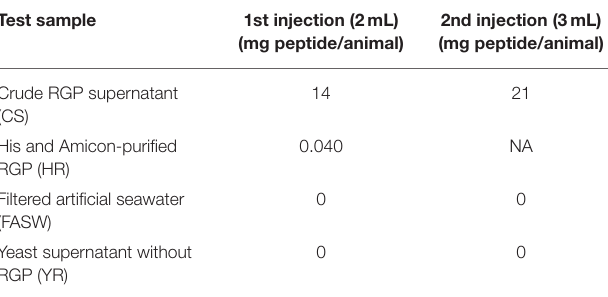
TABLE 1 | Schedule and concentration for the tested sample injections into female Holothuria scabra . Test